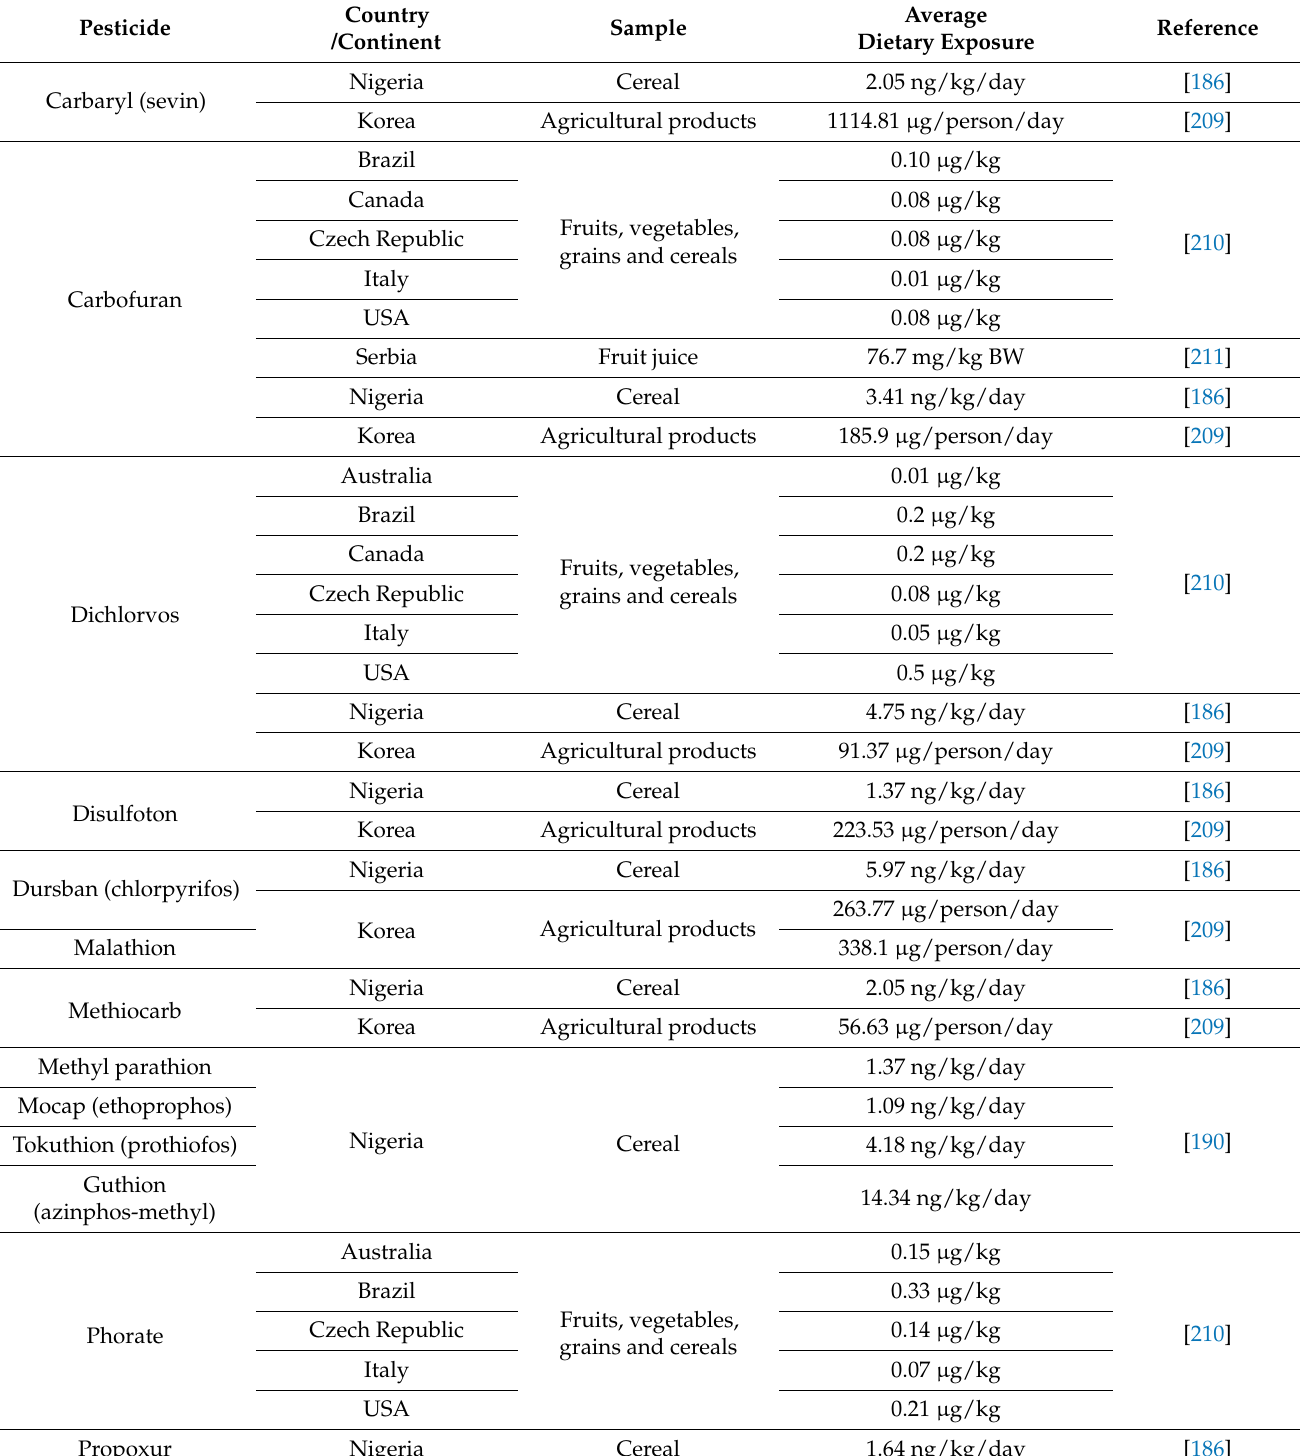
Table 8. Human exposure to pesticides in grains depending on the